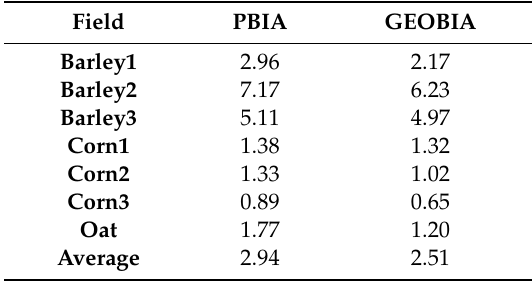
Table 9. Random forest pixel-based image analysis and geographic object-based image analysis out-of-bag error rates (%) as a function of the field.